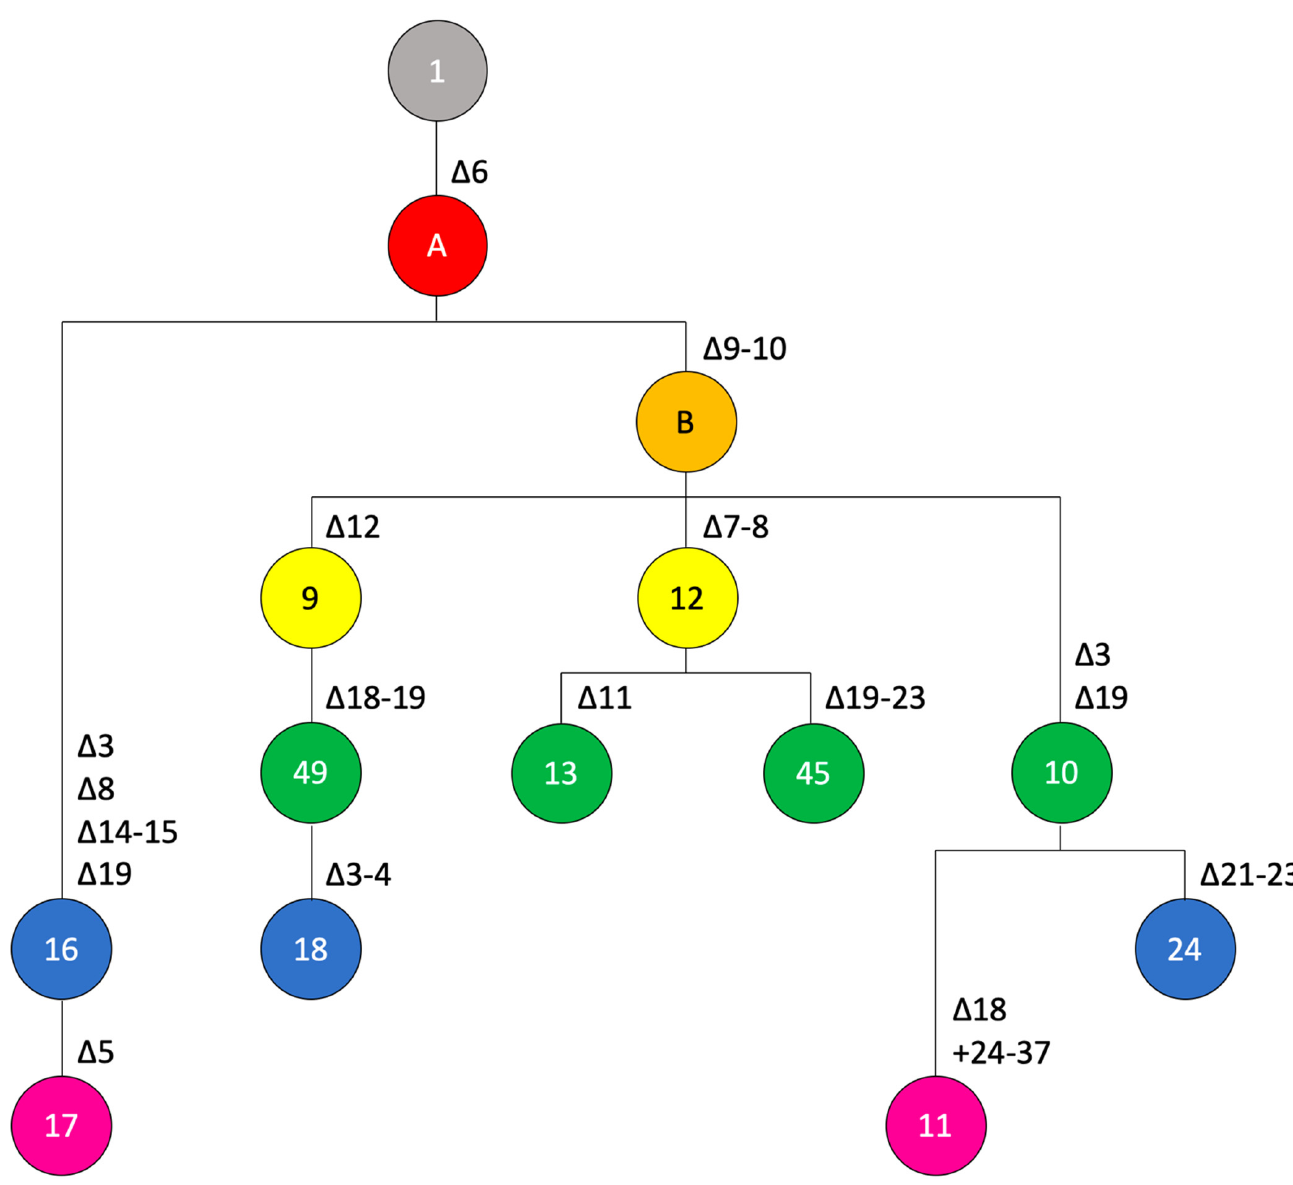
Figure 2. Genealogy of spoligotypes from pathotype-A* strains. Postulated mutational events leading to the observed spoligotypes are indicated, starting from the ancestral spoligotype with all 23 spacers shown in grey on the top, with the colors indicating the number of events (from one to six events, colored in salmon, orange, yellow, green, blue and pink, respectively). Numbers of spoligotypes are indicated in the circles. Characters, i.e., A and B, indicate postulated intermediate spoligotypes that were not observed among the analyzed pathotype-A* strains. Spoligotype 13 was not observed in any of the analyzed genome sequences but had been found in strain LE065-1 previously